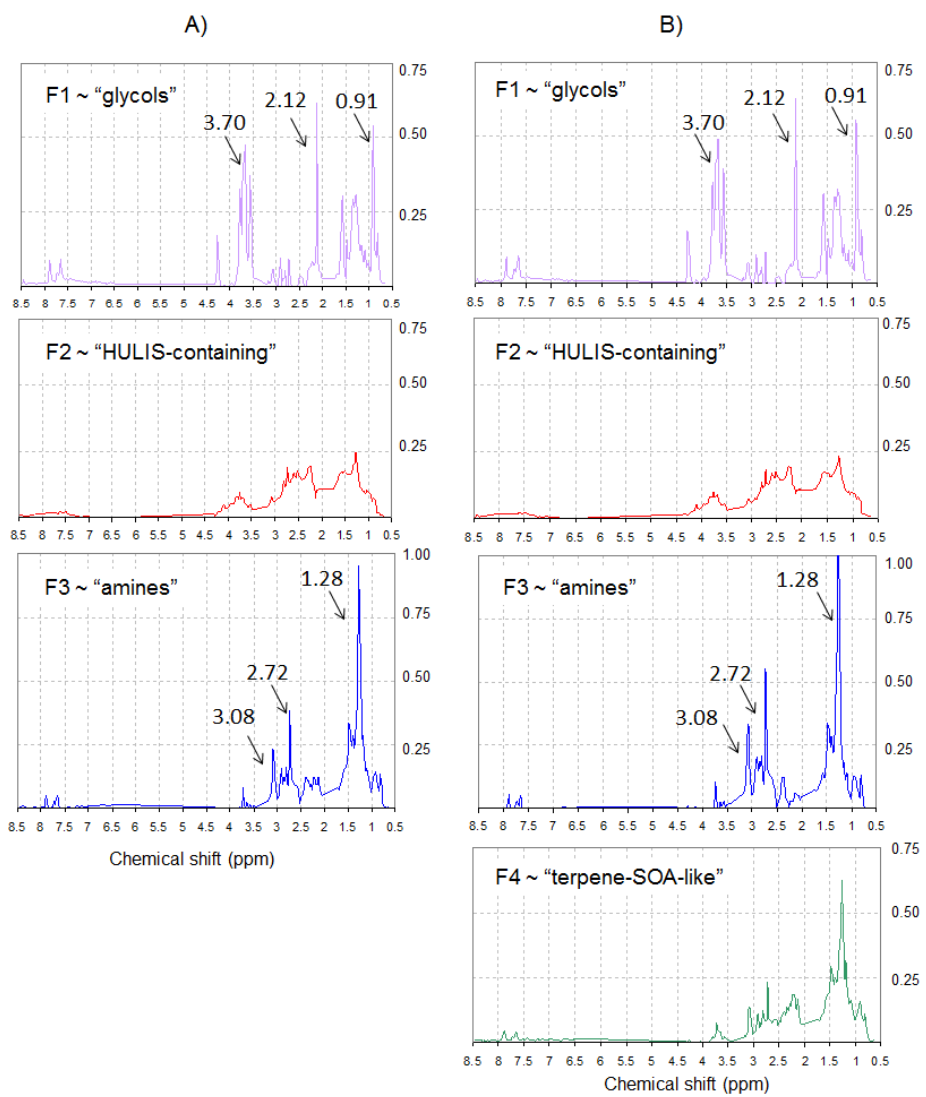
Fig. 8. NMR-factor profiles isolated by applying the MCR-ALS model with a 3-factor solution (a) , and a 4-factor solution (b) . All factor profiles are vertically normalized to 1 and are plotted versus the NMR chemical